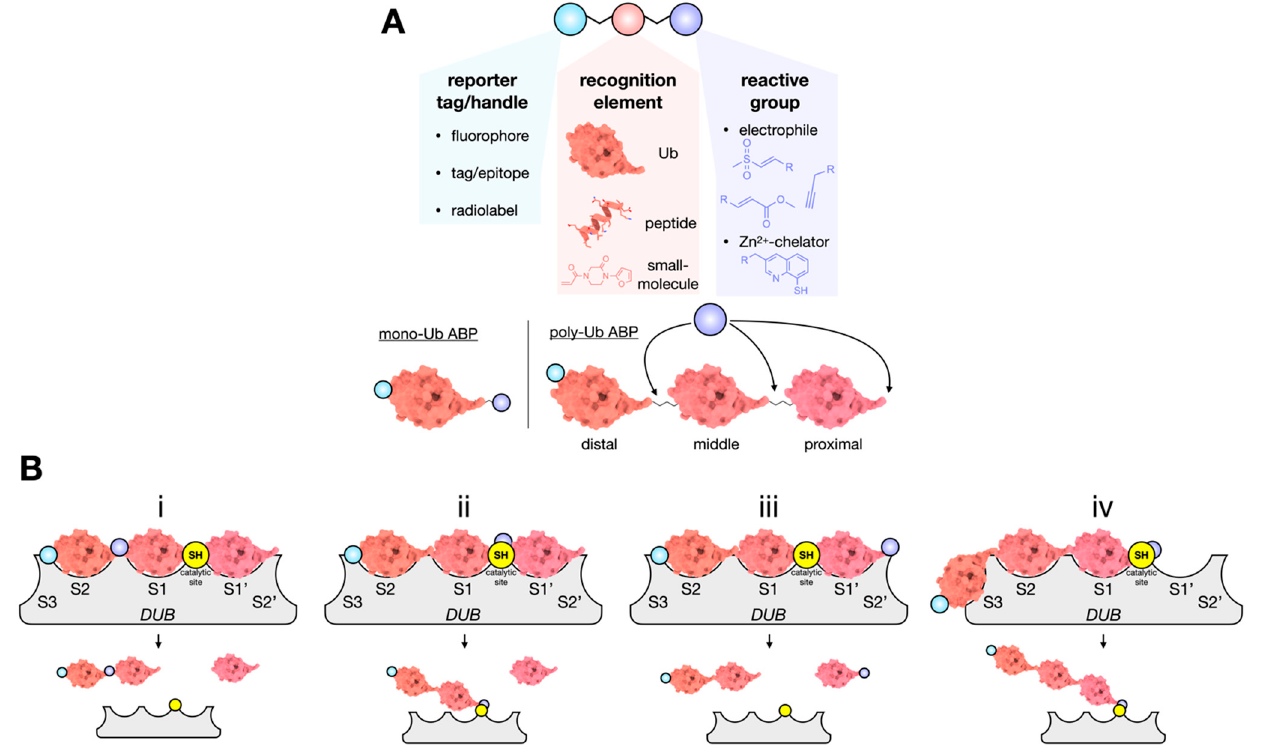
Figure 3. Design of a DUB-targeting ABP. ( A ) Many combinations of the reporter tag, recognition element, and reactive group are possible. For mono-Ub ABPs, the reactive group is placed on the C-terminus. For poly-Ub ABPs, an electrophilic warhead can be strategically placed depending on the DUB cleavage mechanism. Presently, zinc--chelating ABPs for metalloDUBs have only been generated using a C-terminal reactive (chelating) group. ( B ) For poly-Ub ABPs (a tri-Ub ABP, as shown), the substrate must first be recognized and bound by the DUB, a mechanism dependent on the Ub linkage type, chain length, and binding sites (S3 − S2’ depicted). Productive catalysis takes place when the scissile bond spans the catalytic site between the S1 and S1’ Ub-binding sites. As shown, only when the reactive group is oriented appropriately will activity-based labelling occur (see ii and iv). Schematic representation of some, but not all, possible outcomes for a tri-Ub ABP bound to a DUB with multiple Ub-binding sites.